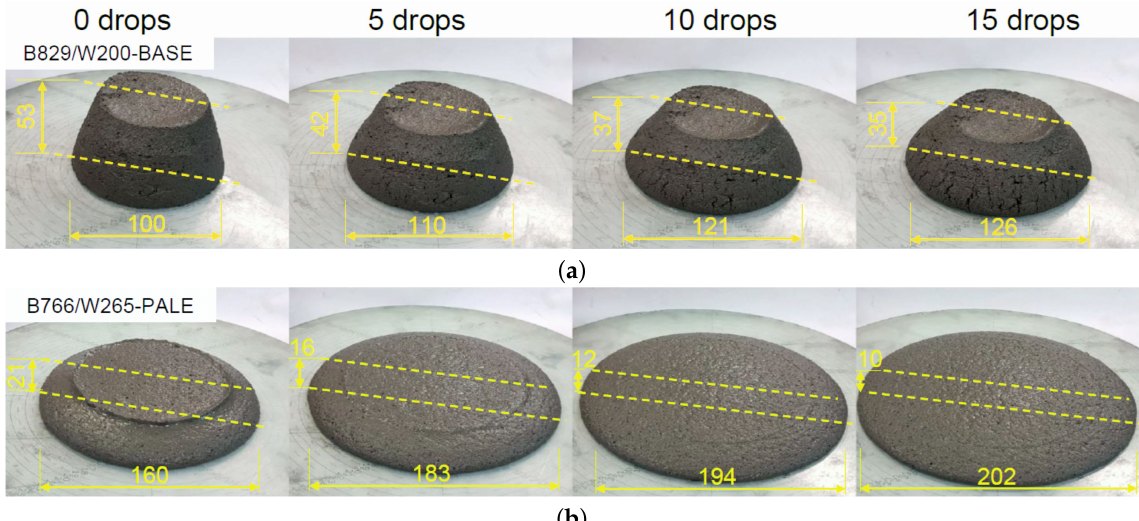
Figure 7. Testing the consistency of 3D mortars using the slump-flow table method: ( a ) initial mortar B829/W200—BASE [19], ( b ) modified mortar B766/W265—PALE.